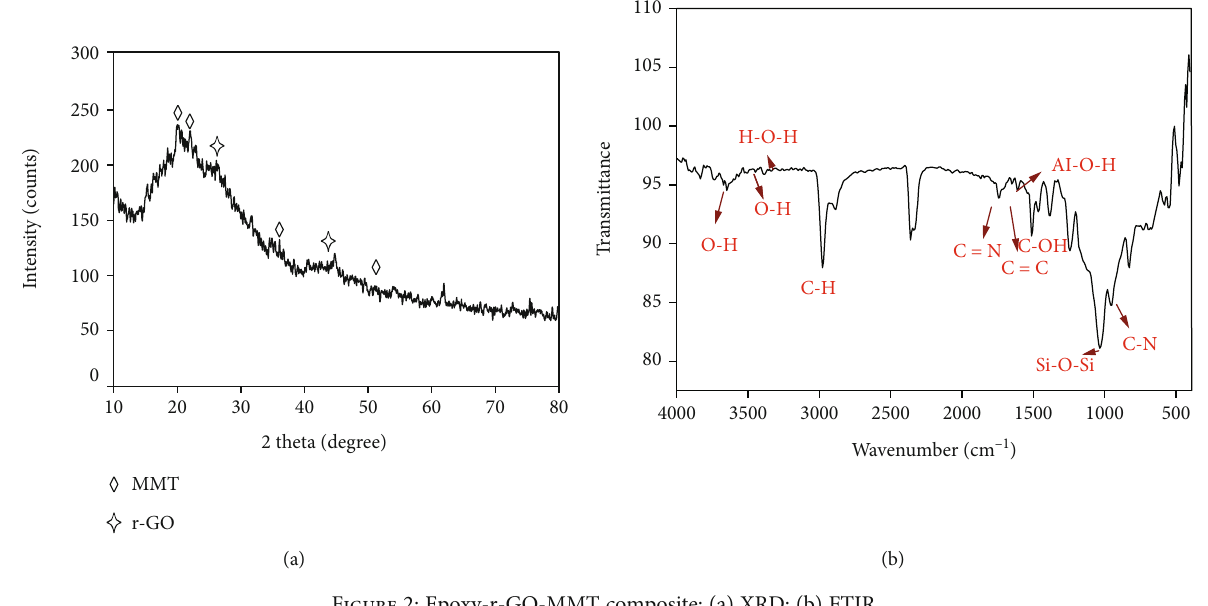
Figure 2: Epoxy-r-GO-MMT composite: (a) XRD; (b) FTIR.